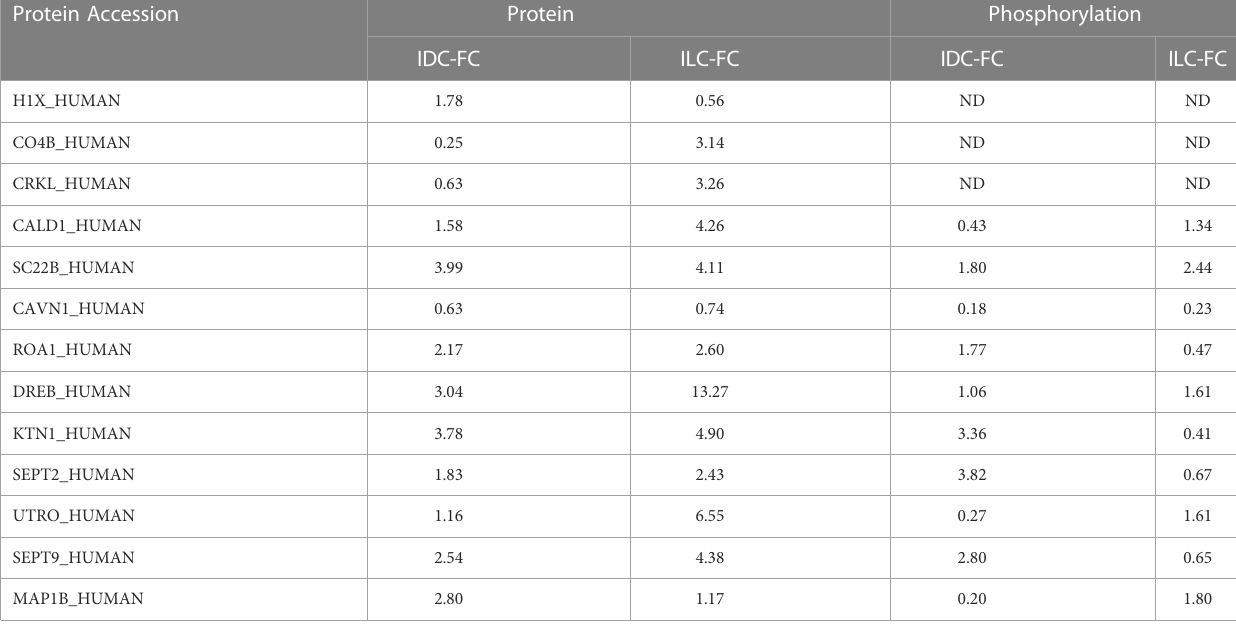
TABLE 2 Differential proteins and their phosphorylation between IDC and ILC compared with their respective NATs. Protein